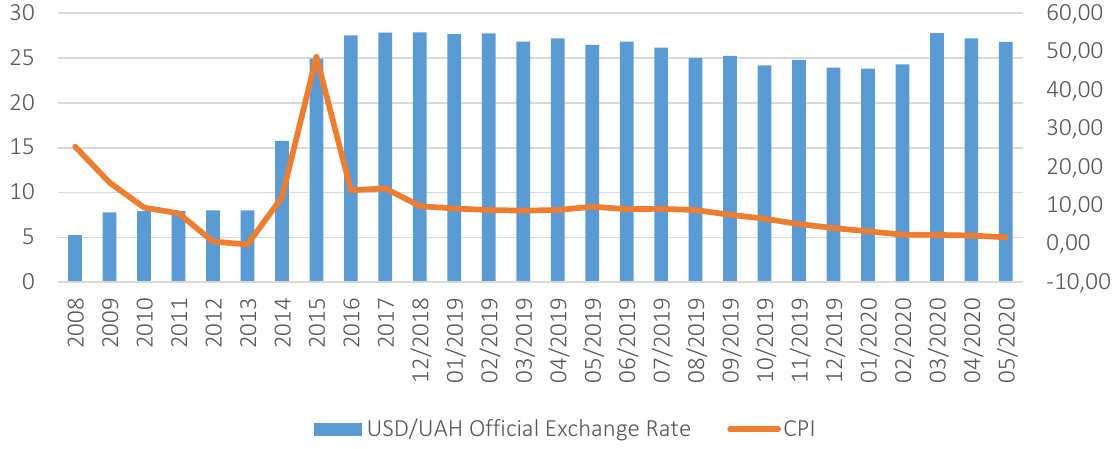
Figure 2. Dynamics of the USD/UAH official exchange rate and CPI, 2008 – May